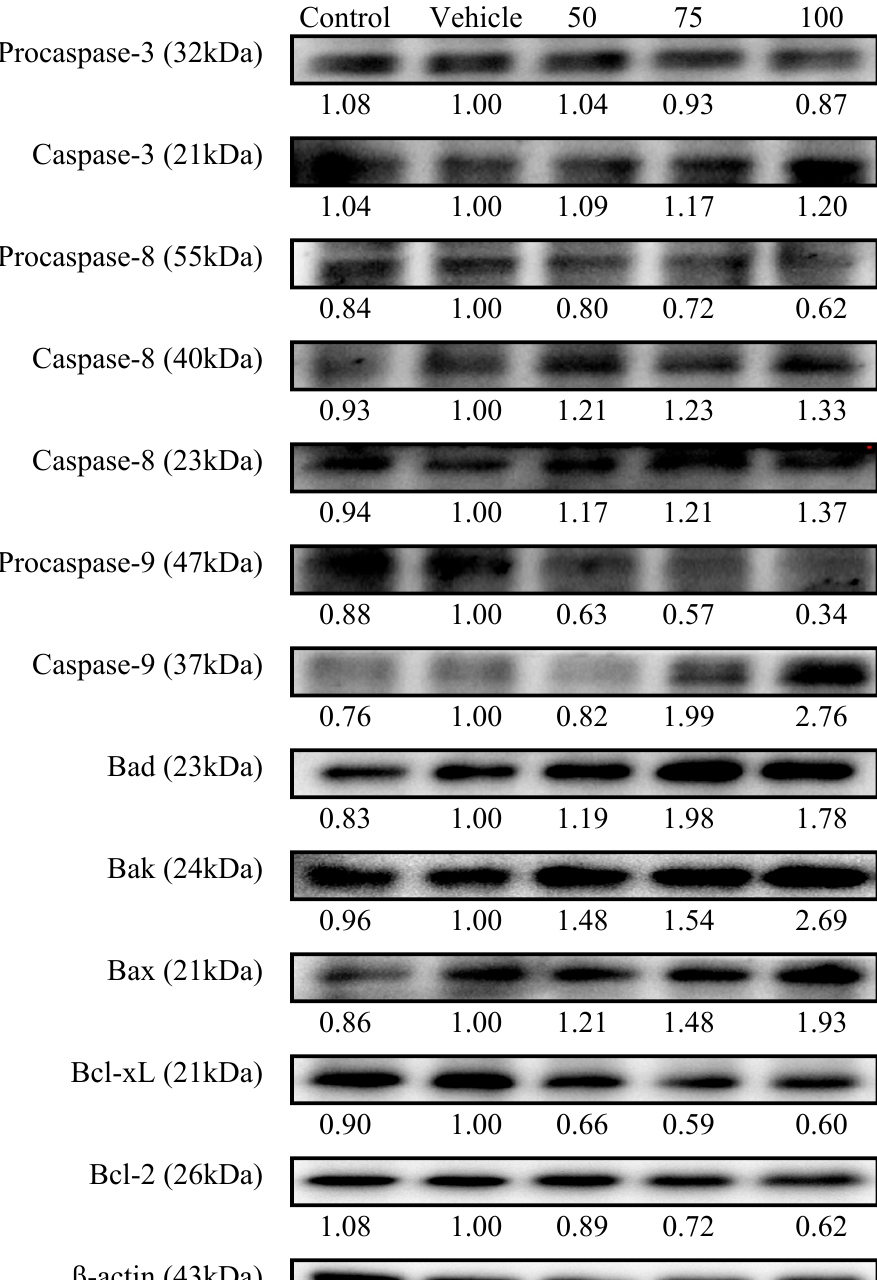
Figure 4. Western blot analysis of apoptosis-related proteins in RL95-2 cells treated with SOE. Caspase-3, -8, -9, Bad, Bak, Bax, Bcl-xL and Bcl-2 proteins in RL95-2 cells after treatment with 0–100 μ g/mL SOE for 24 h were detected. Whole-cell lysates were subjected to Western blot assays and β -actin was used as an internal control. The relative density of the proteins was determined by densitometric analysis. The values indicate the density proportion of each protein compared with